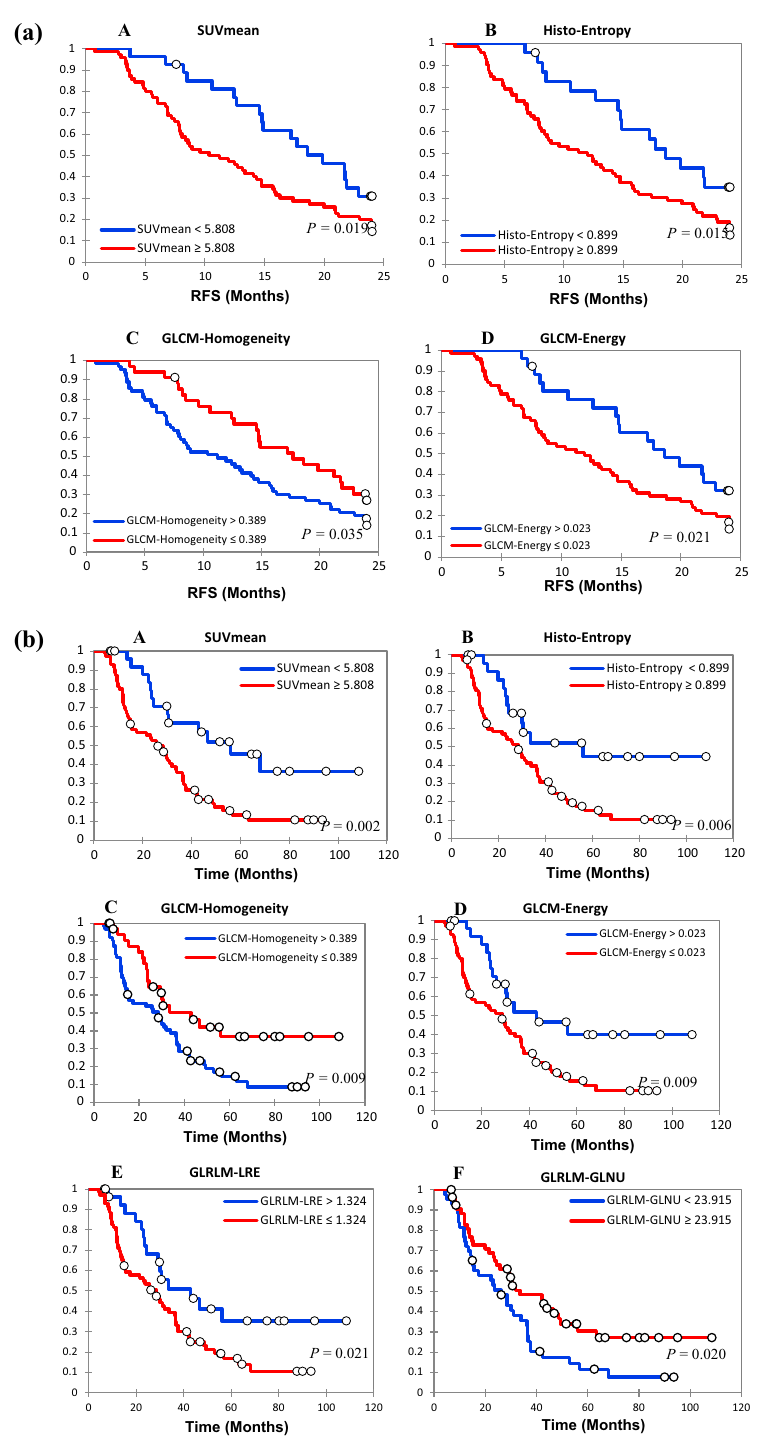
Figure 3. ( a ) Kaplan–Meier estimates of relapse free survival (RFS) between 2 groups according to optimal cut-off: A (SUVmean), B (Histo-Entropy), C (GLCM-Homogeneity), D (GLCM-Energy). ( b ) Kaplan–Meier estimates of overall survival (OS) between 2 groups according to optimal cut-off: A (SUVmean), B (Histo- Entropy), C (GLCM-Homogeneity), D (GLCM-Energy), E (GLRLM-LNE), F